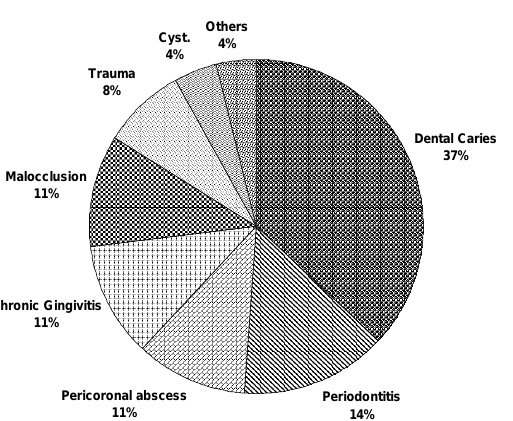
Figure 1: Pattern of Dental Diseases (n-279)